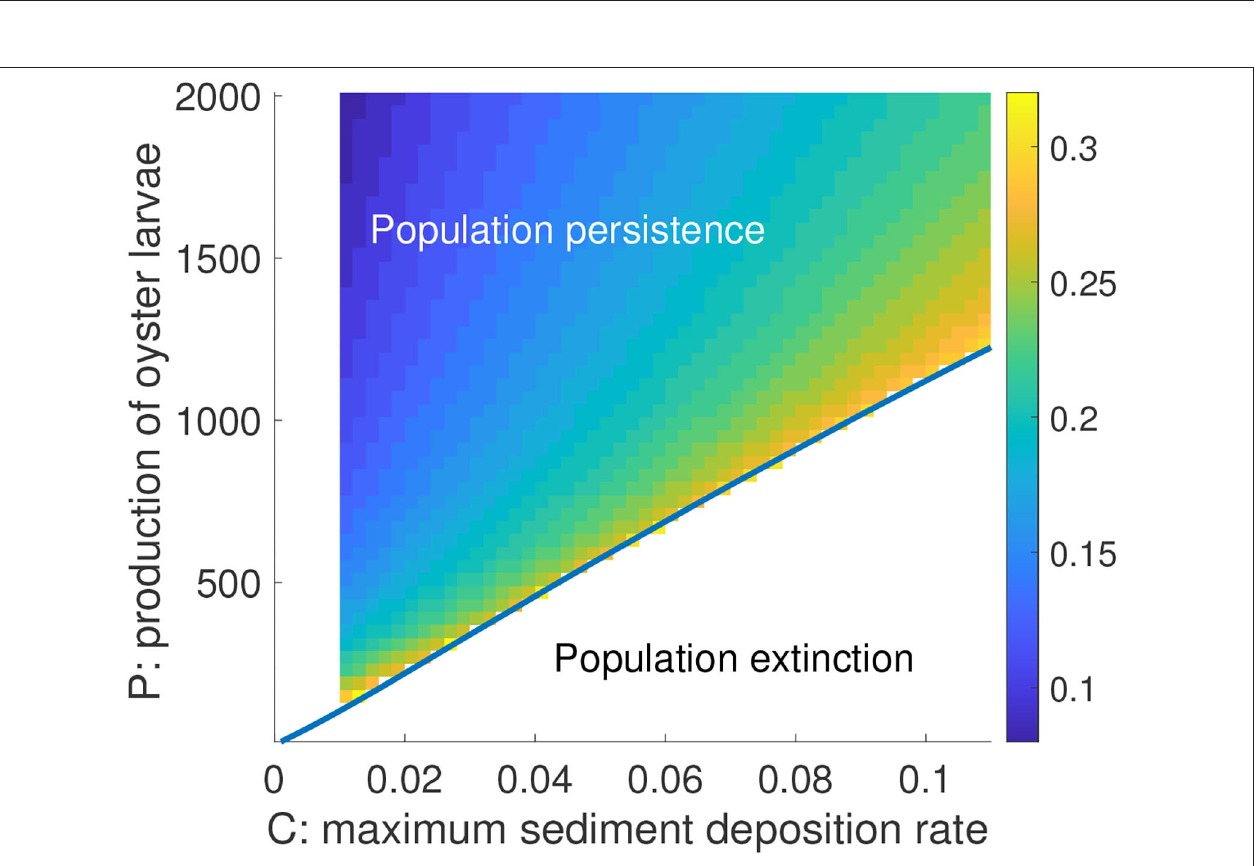
FIGURE 9 | Critical reef height R 0 c as a function of C and P in a 2-d color gradient representation. Blue curve is a superimposed bifurcation curve showing the saddle-node bifurcation point with respect to the joint effects of parameters C and P . Non-extinct outcomes exist only above the curve (including in the region of very small sediment deposition rates where R 0 c was not computed). Other parameters are as in Table 2 . The vertical bar legend to the right of the graph represents a gradient of R 0 in